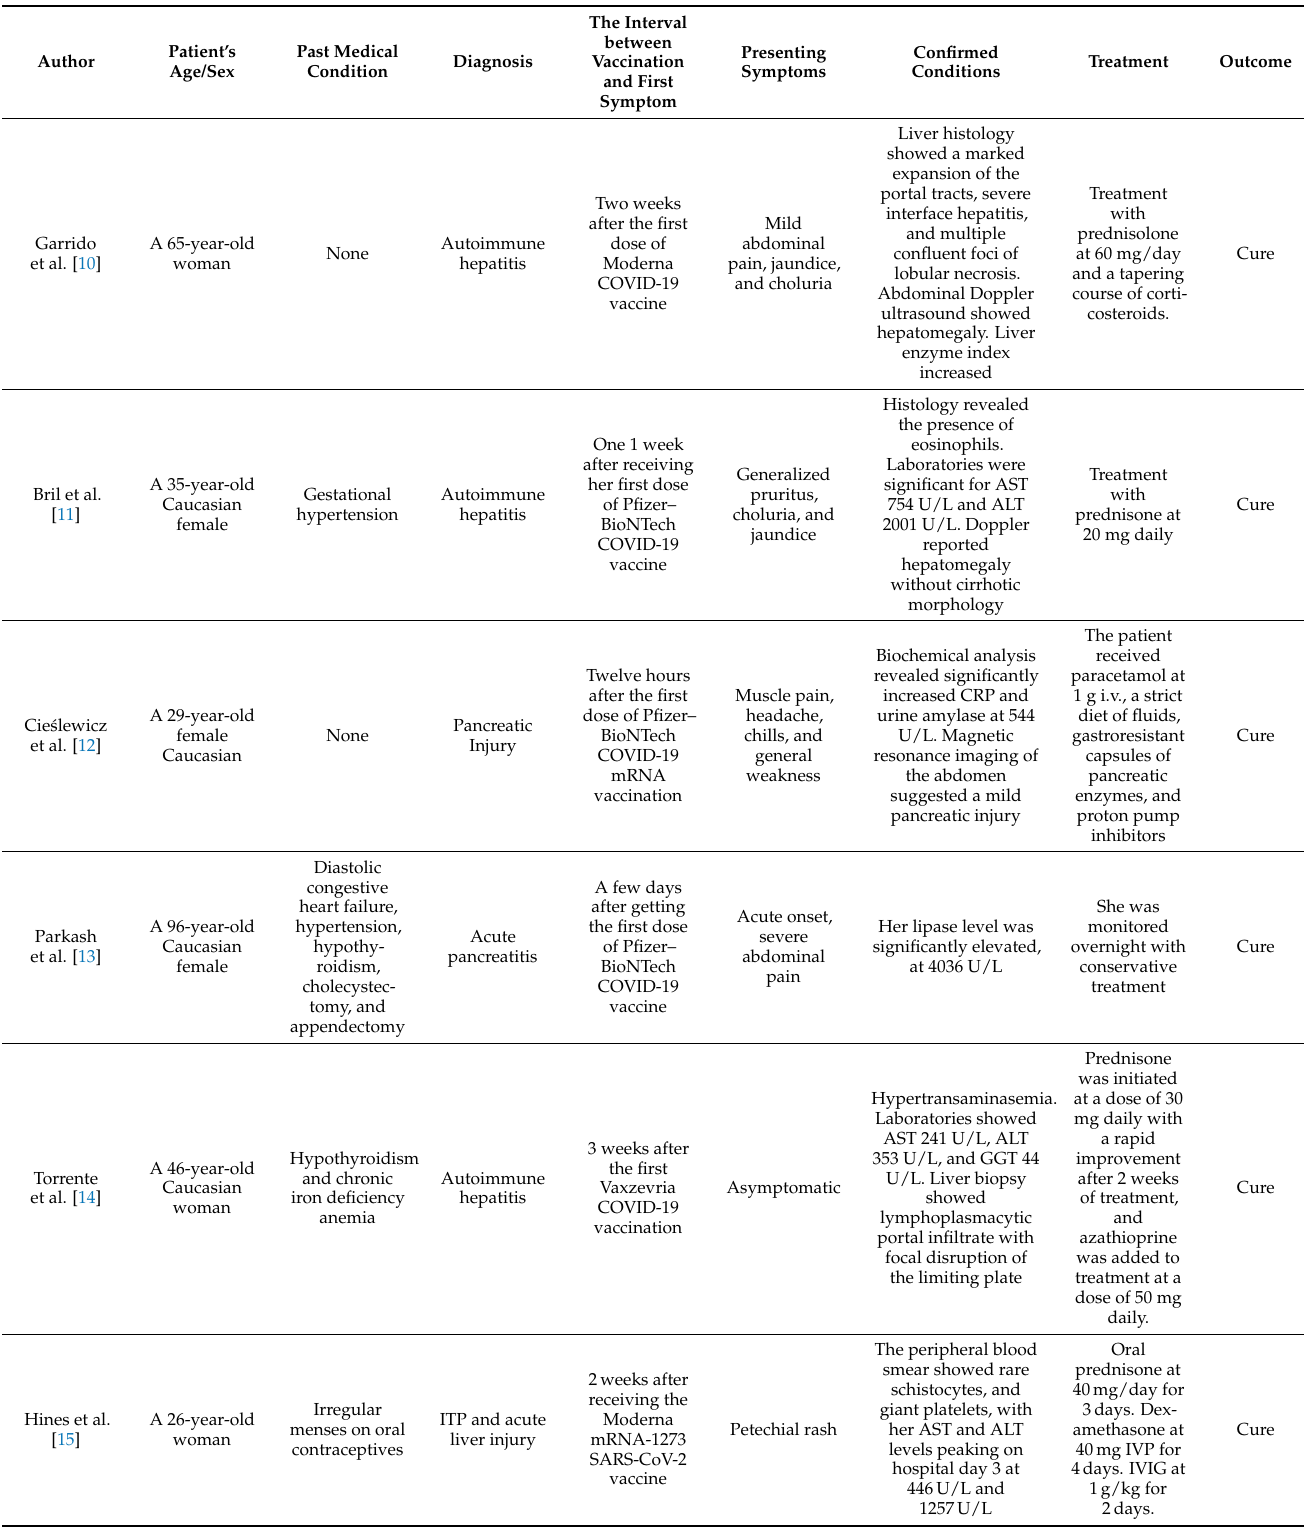
Table 1. Summary of some reported cases of COVID-19-vaccine-related